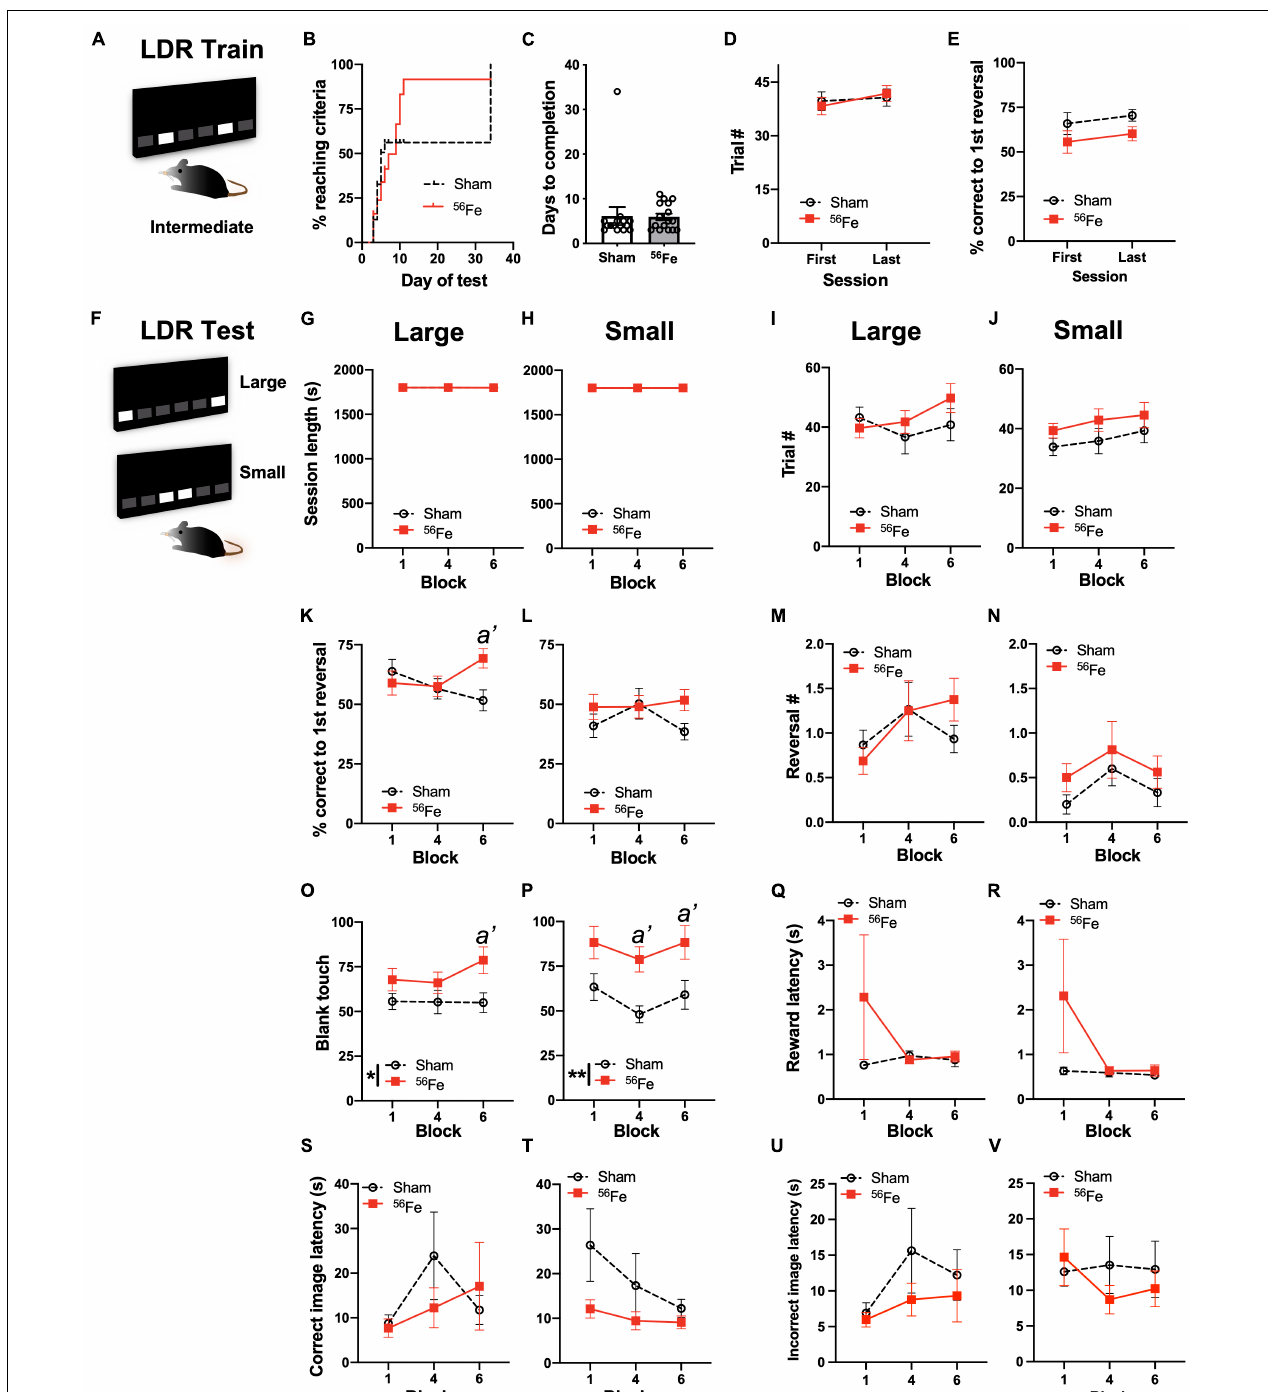
FIGURE 3 | On an appetitive, touchscreen discrimination learning task, female mice exposed to whole-body 56 Fe IRR at 6-mon of age perform better than Sham mice in discriminating the location of two identical visual cues. (A) Schematic of the lit squares and their Intermediate separation which are used for location discrimination reversal training (LDR Train). (B–E) Sham and 56 Fe IRR mice performed similarly in LDR Train based on (B) distribution of subjects reaching criteria (the visual difference in percent of Sham and 56 Fe subjects reaching criteria was rejected by survival curve analysis), (C) days to completion, (D) trials completed, and (E) % correct to 1st reversal. (F) Schematic of the lit squares and their Large and Small separation used for LDR testing (LDR Test). (G–V) When mice underwent LDR Test with squares maximally-separated (Large separation, G,I,K,M,O,Q,S,U ) or minimally-separated (Small separation, H,J,L,N,P,R,T,V ), there was no difference between IRR and Sham mice in session length (G,H) or number of completed trials (I,J) on the last day of the 1st, 4th, and 6th 2-day block. However, in the Large -